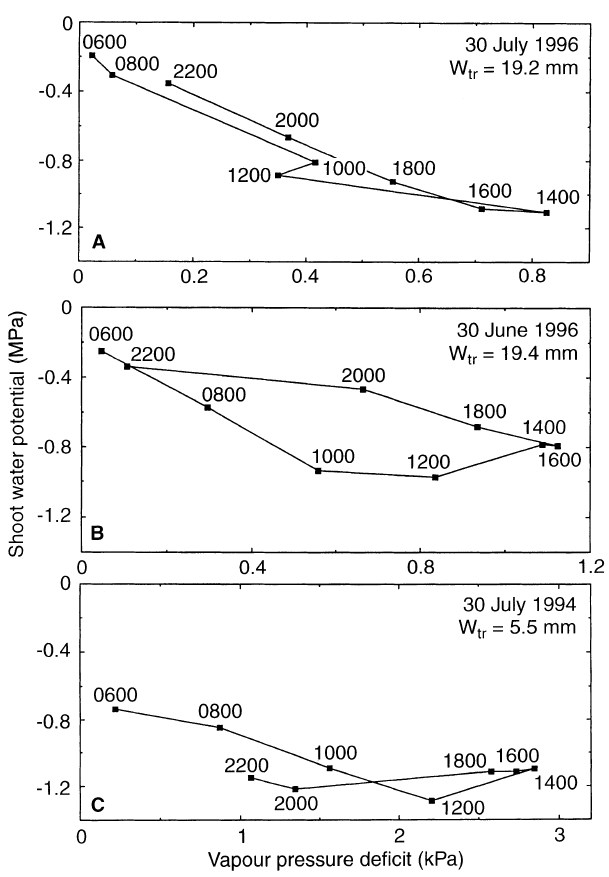
Fig. 5A–C . Daily patterns of the shoot water potential depending on the combination of air and soil conditions. A high soil water availability and low atmospheric evaporative demand; B high soil water availability and high atmospheric evaporative demand; C low soil water availability and high atmospheric evaporative demand. Note, the horizontal axes for A , B and C are di(cid:128)erent